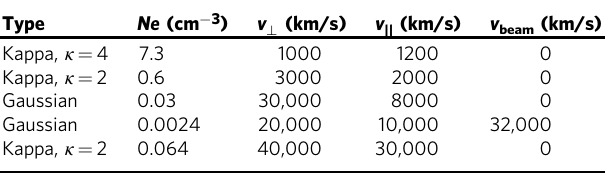
Table 1 The fi tting parameters for the electron distribution shown in Fig.